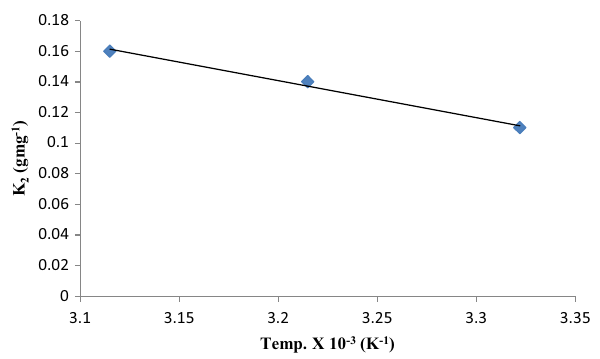
Fig. 11 Intraparticle diffusion plots for adsorption of CR dye on MSC at different temperatures Table 4 Adsorption mechanism parameters for adsorption of CR